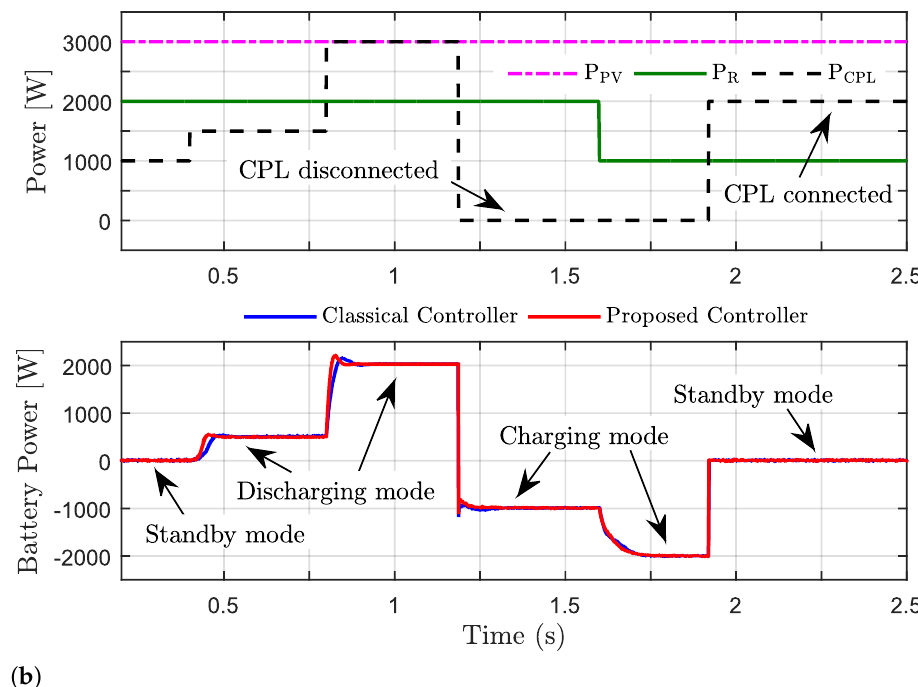
Figure 11. Simulated Case 2: ( a ) dc–bus voltage; ( b ) microgrid power flow time–domain.